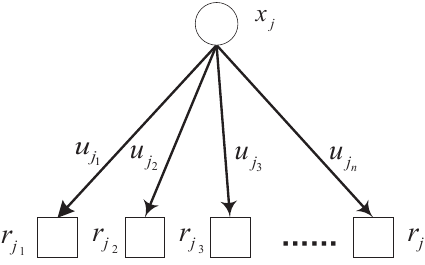
Figure 4. Variable node conveys message to its all neighboring symbol